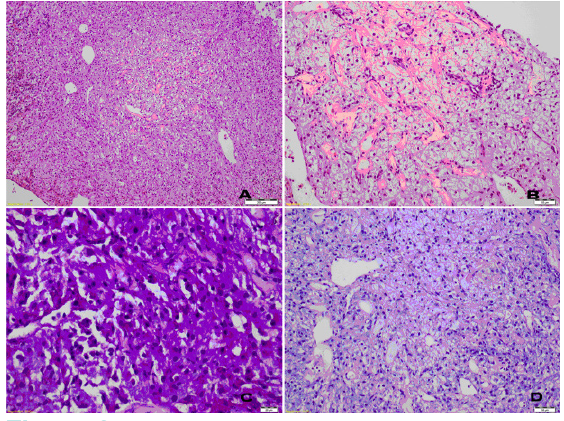
Figure 2. Photomicrograph showing round to oval cells with uniform nuclei and abundant clear cytoplasm (A and B); most neoplastic clear cells had intracytoplasmic PAS-positivity (C); these disappeared following diastase digestion (D).